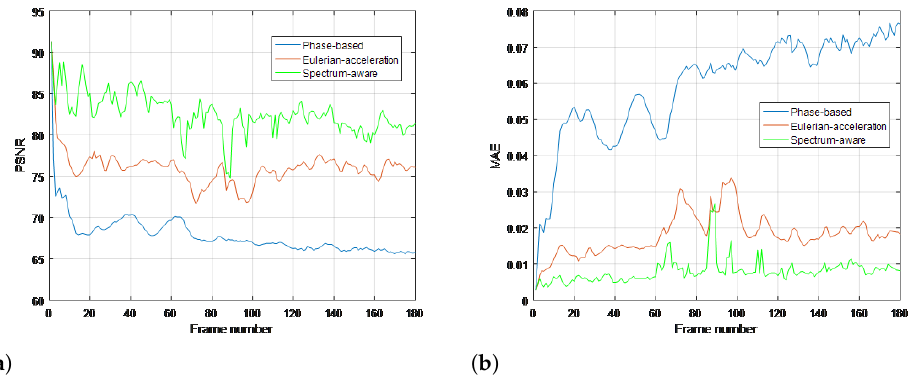
Figure 10. Objective metrics with ground truth for each magnification processing using ( a ) PSNR and ( b ) MAE in bottle